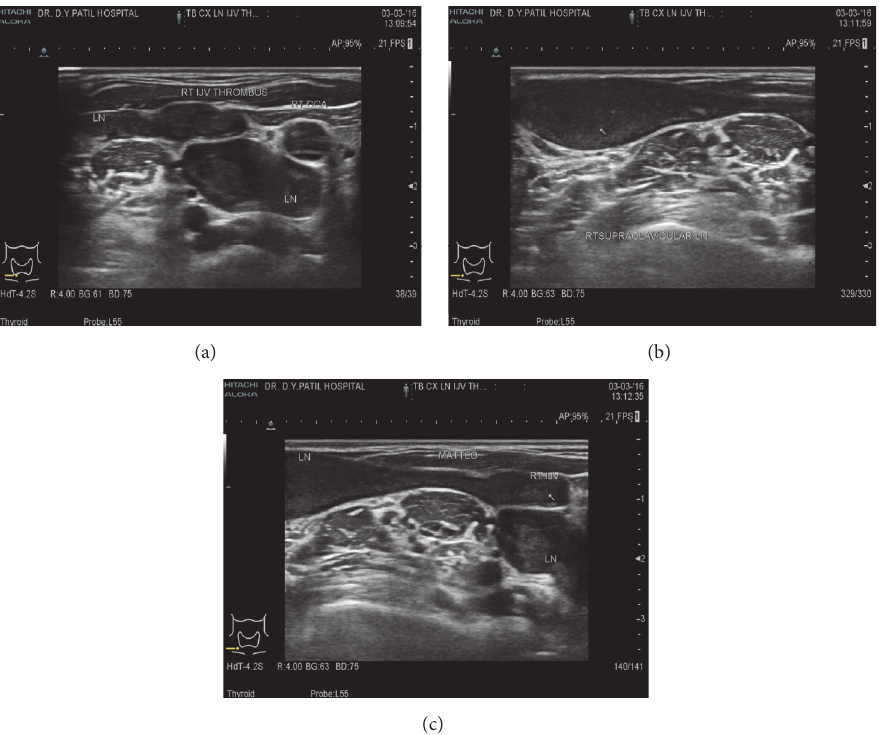
Figure 1: USG neck showing well-defined hypoechoic lymph nodes posterior to right CCA and IJV and in the right supraclavicular region at level IV with echogenic thrombus in right IJV.